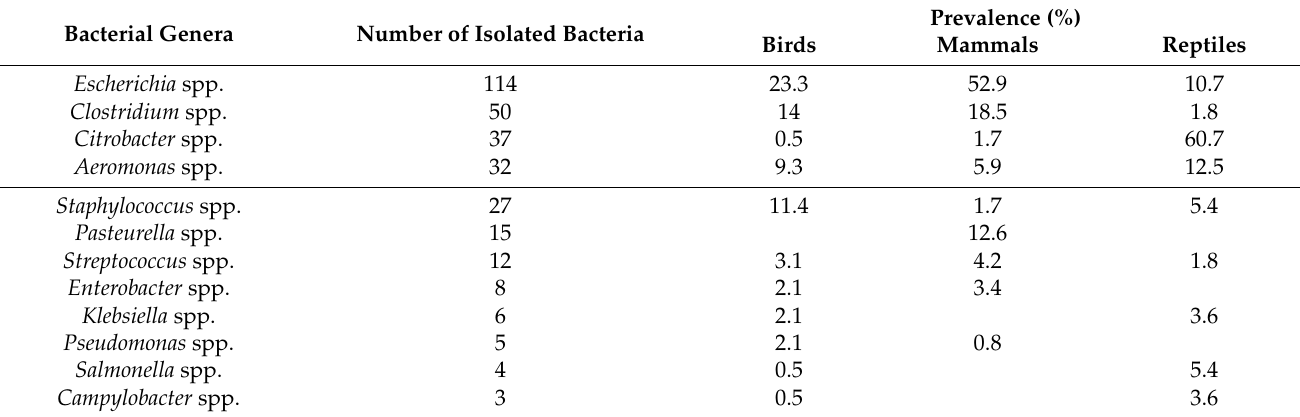
Prevalence (%) Birds Mammals Reptiles 114